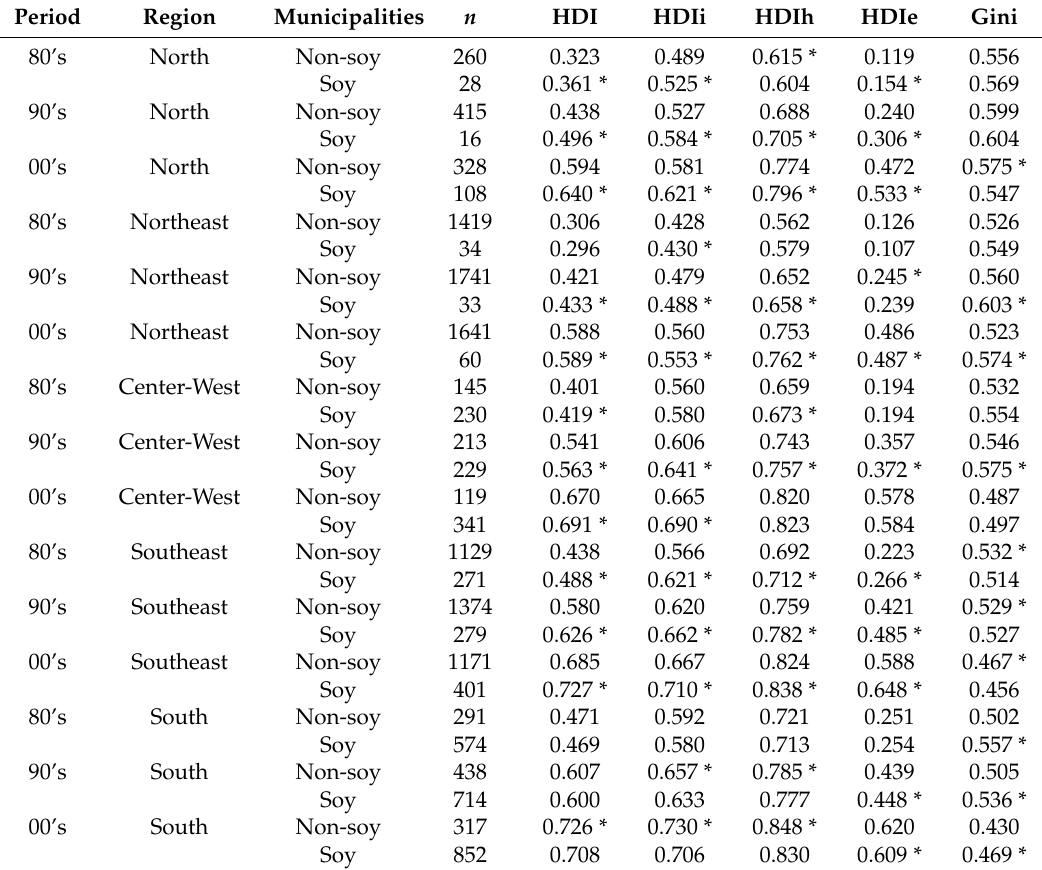
Table 2. The Human Development Index (HDI), its three components: income (HDIi), health (HDIh), education (HDIe), and the Gini coefficient for income for the five geographical regions of Brazil in the 1980s, 1990s and 2000s. Statistical differences at 5% probability level are indicated by